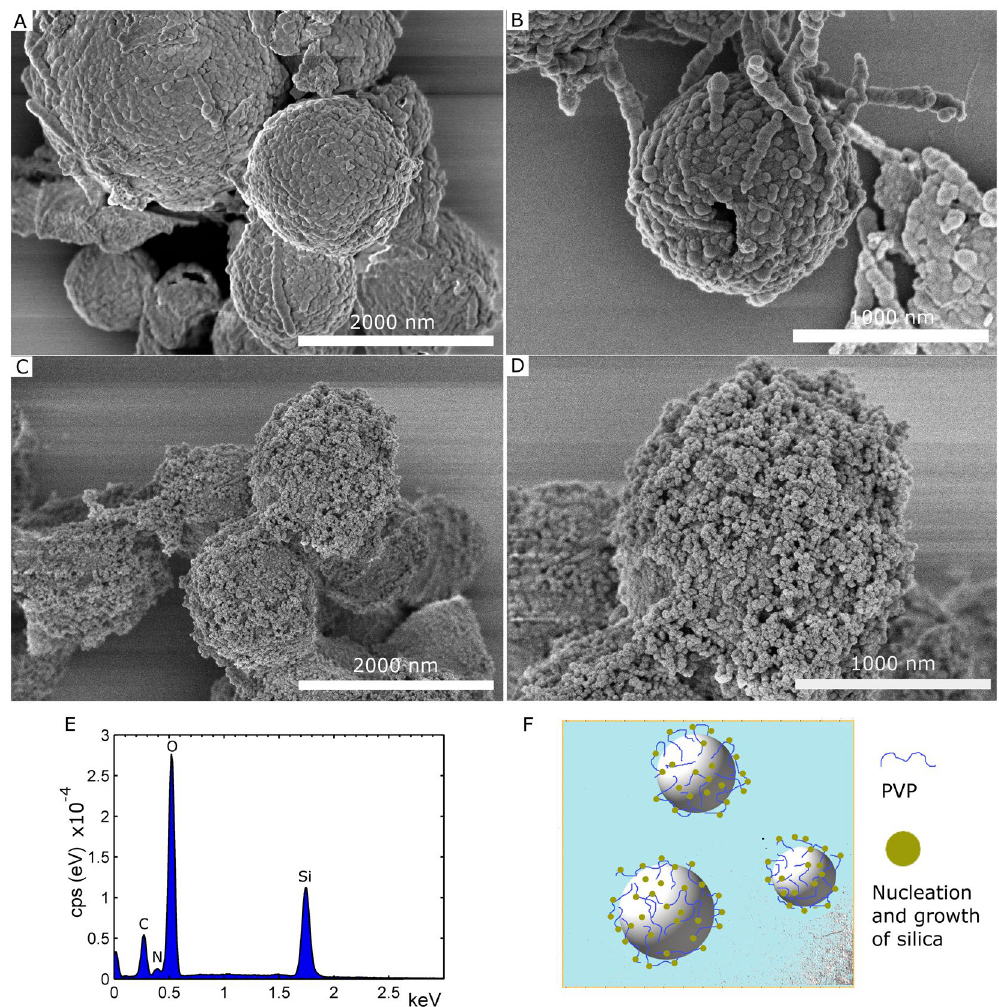
Figure 2. SEM images at two different magnifications of capsules coated with SiO x nanostructures. In ( A , B ) the resulting raspberry-like capsules were obtained by adding TEOS to a precursor capsule suspension. In ( C , D ) the rougher outer structure of broccoli-like capsules was achieved by adsorbing PVP onto precursor capsules prior to the addition of TEOS. ( E ) EDS spectrum of the raspberry-like capsules shown in ( A , B ). ( F ) Proposed model of the adsorption of PVP and subsequent nucleation and growth of silica on the outer wall of broccoli-like capsules shown in ( C ) and ( D